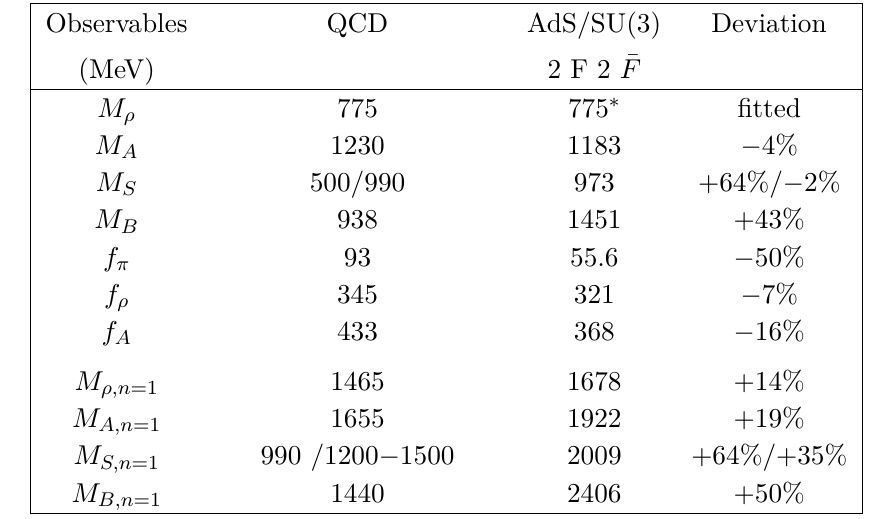
Table 1. The predictions for masses and decay constants (in MeV) for N f = 2 massless QCD. The ρ -meson mass has been used to set the scale (indicated by the